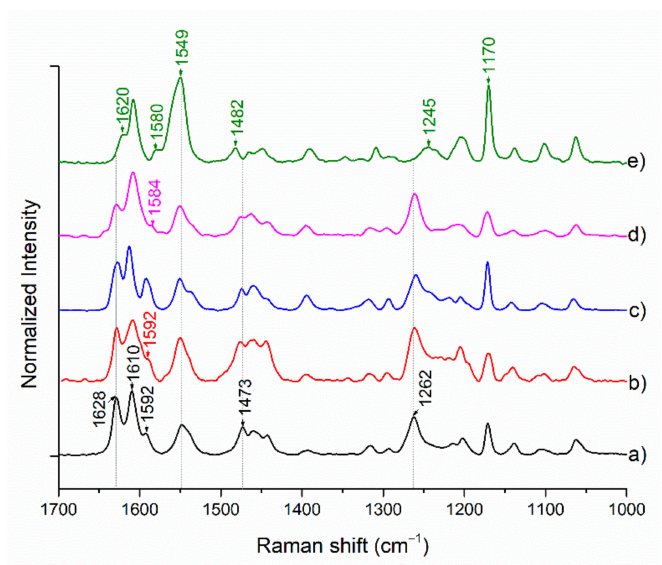
Figure 12. Raman spectra of ( a ) xanthohumol and the target cocrystals: ( b ) XN − GA, ( c ) XN − AC, ( d ) XN − NIC, and ( e ) XN −